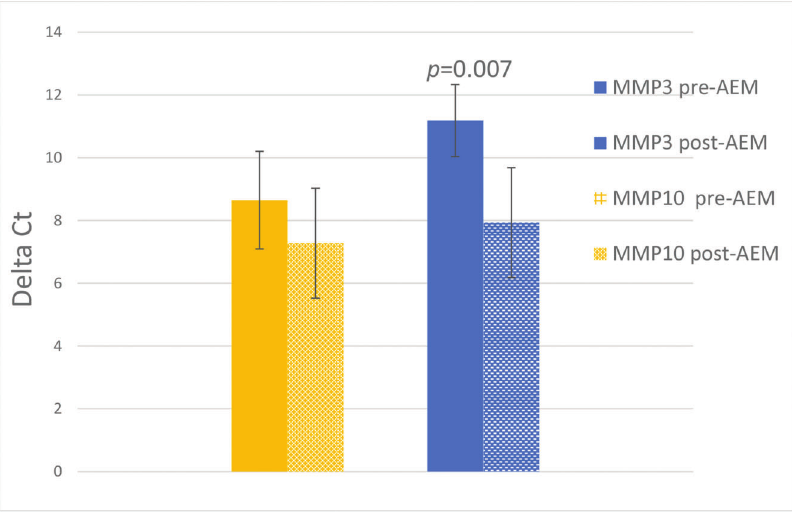
Figure 1 - Relative expression of MMP3 and MMP10 before and after arterial embolization of myomas (AEM) (mean ± SEM); N=7. The Y-axis represents the deltaCt values (mean Ct of the target gene-mean Ct of the endogenous genes). The vertical lines indicate the mean and standard error for each of the samples. * p